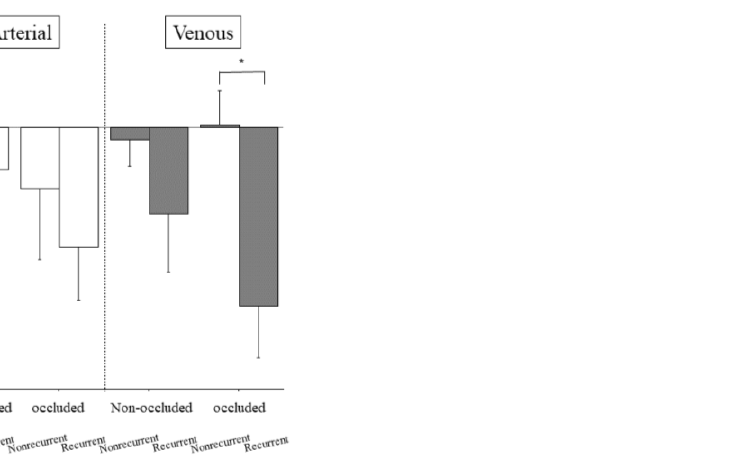
Table 3. Aqueous humor levels of factors/cytokines and the aqueous flare value at recurrence.